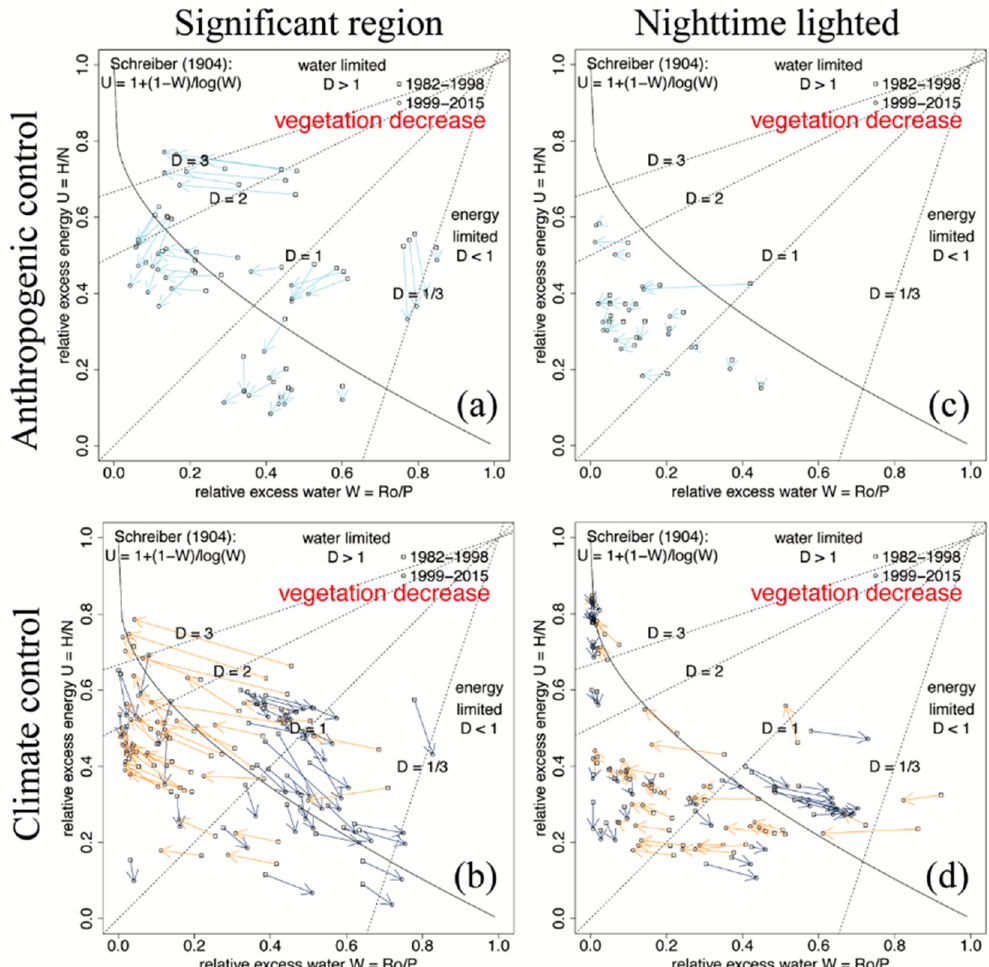
Figure 4. Trajectories of excess energy and water ( U,W ) change in regions of decreasing vegetation. Directions and lengths of arrows connecting first with second period provide the attribution of change of the internal / anthropogenic and external / climate partitioning (see text): ( a , b ) Internal-external partitioning in regions with significant ( U,W ) change (exceeding the std( U ) or std( W )); and ( c , d ) internal-external partitioning in urbanization (nighttime lighted) areas of Asia and